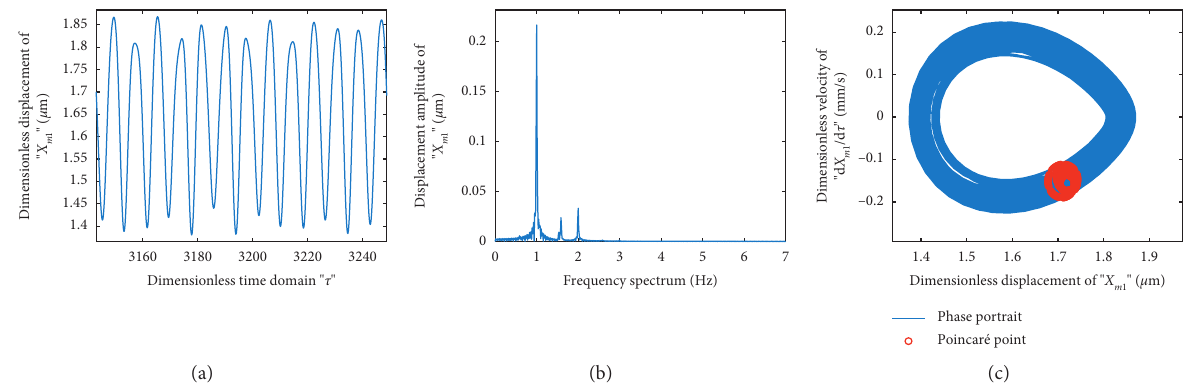
Figure 8: The dynamic response of system X